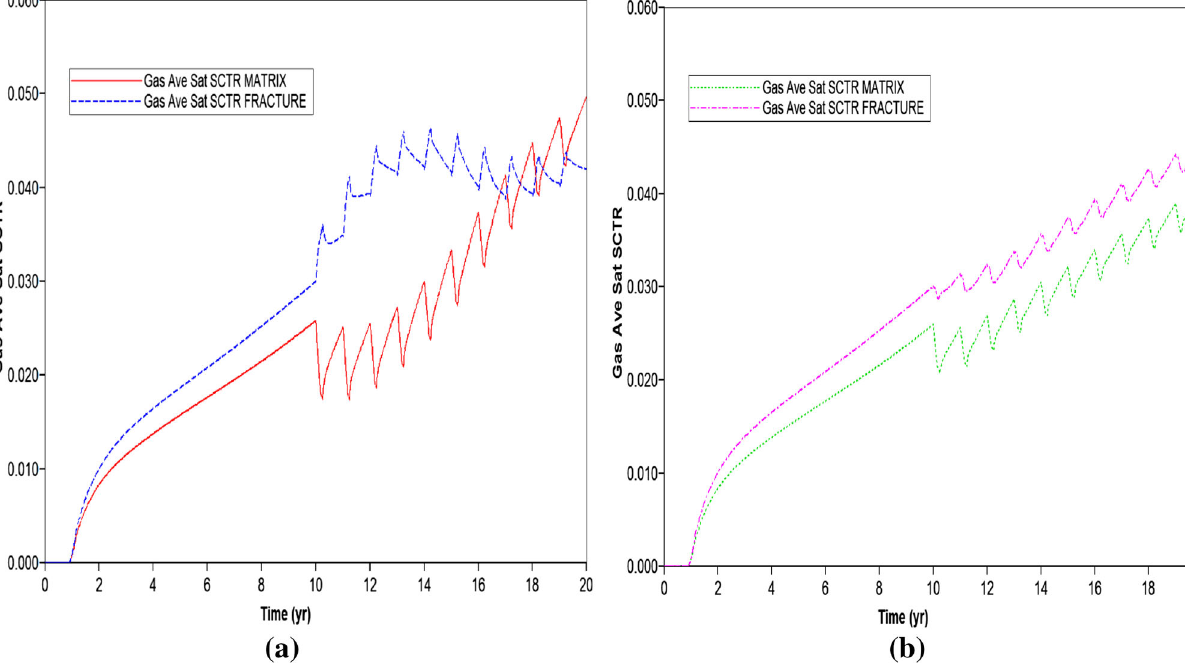
Fig. 14 Gas saturation distribution in matrix versus fracture (molar diffusion mechanism is OFF). a Lean gas. b CO